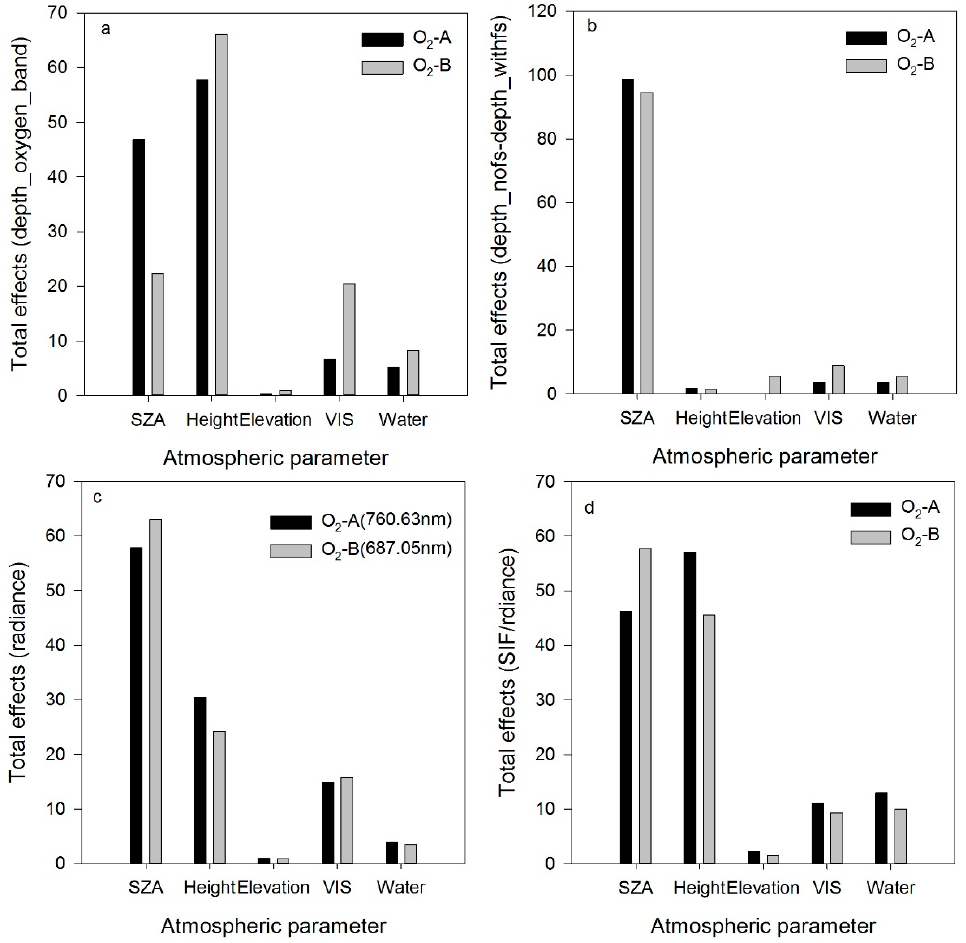
Figure 3. Results of sensitivity analysis. Four indicators are selected: ( a ) depth_oxygen_band; ( b ) depth_nofs-depth_withfs; ( c ) radiance; and ( d ) SIF/radiance.